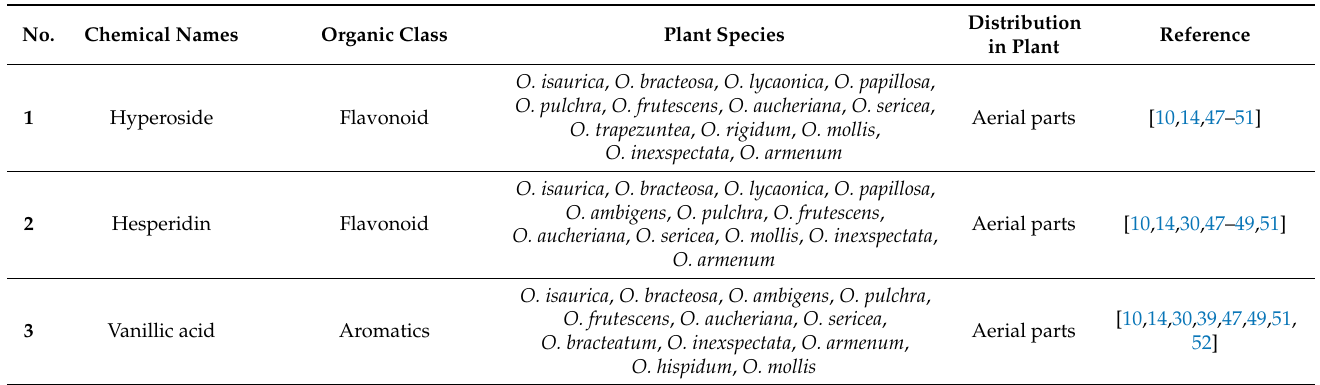
Figure 5. Most common Onosma compounds based on the repetition in the literature.